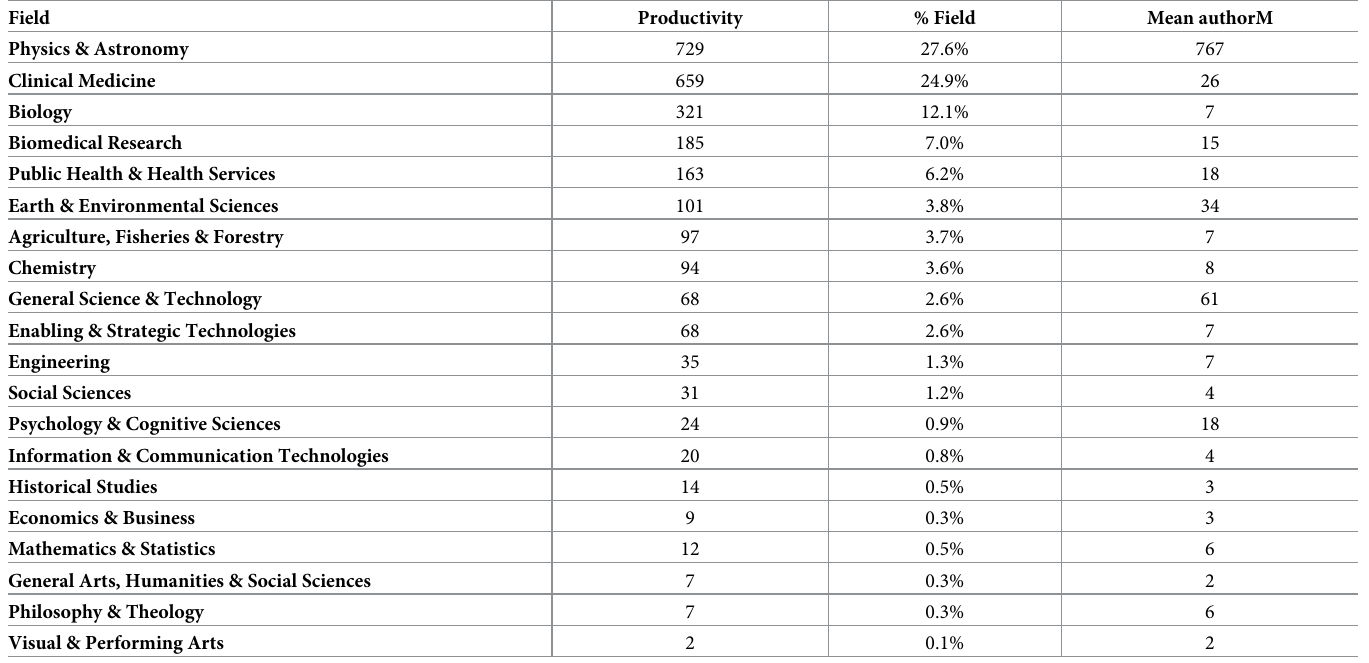
Table 1. Cuban scientific output in collaboration with the U.S. according to the field of research January 1, 1980- December 31, 2020. Field